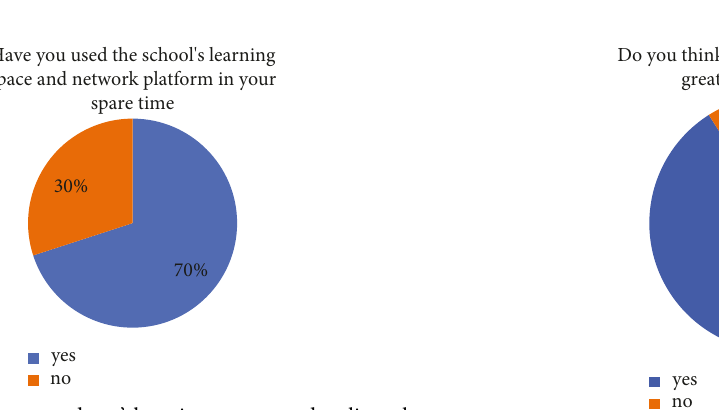
Figure 9: Survey on students’ search for learning knowledge through online channels.